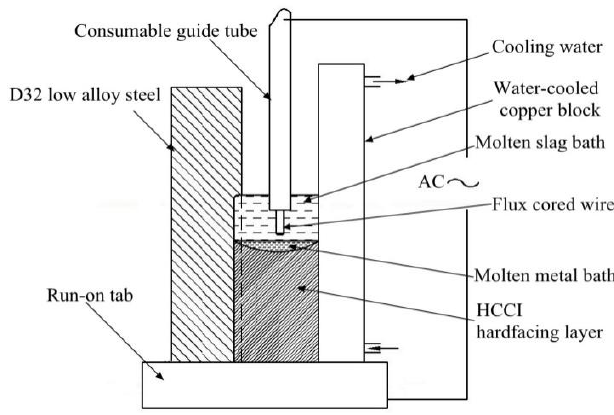
Figure 1. Schematic of the electroslag surfacing.